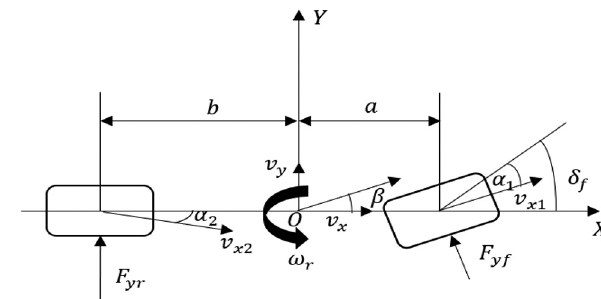
Figure 2 Linear 2-DOF vehicle model with parameter